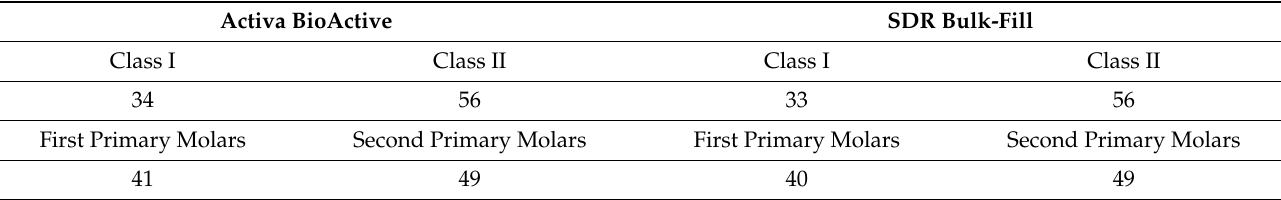
Table 2. Involved teeth and class restoration